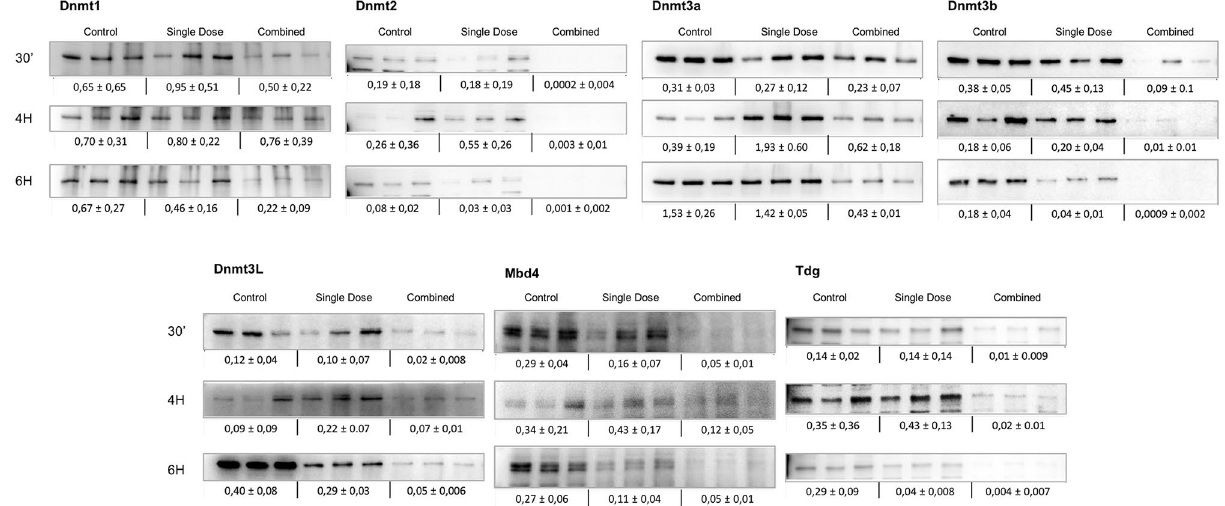
Figure 3. Study of the response of chromatin remodelers to a combined radiation regime versus control or single irradiated mouse thymocytes in vivo. Western blots of 3 biological replicates showing time-dependent changes (30 min, 4 and 6 h) in the expression of several chromatin remodelers such as DNA methylases: DNMT1 (200 kDa), DNMT2 (55 kDa), DNMT3A (130 kDa), DNMT3B (96 kDa) and DNMT3L (49 kDa) and glycosylases such as MBD4 (Methyl Binding Domain) (60–65 kDa) and TDG (Thymine DNA glycosylase) (55–65 kDa) in control thymocytes, thymocytes exposed to a single dose (1.75 Gy) or thymocytes exposed to a radiation combined regime (0.075 Gy + latency + 1.75 Gy). β-Actin was probed as a loading control for each membrane in annexed Fig. 3 Original blots are presented in supplementary